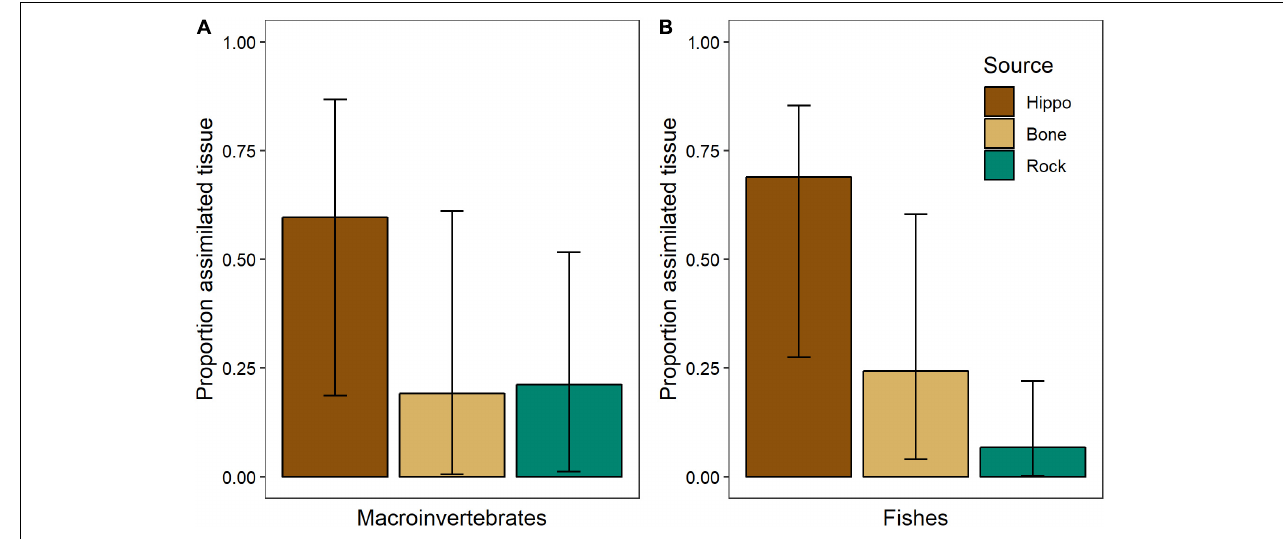
FIGURE 11 | Proportion of basal resources in assimilated tissue (mean and 95% Bayesian credible intervals) of (A) aquatic macroinvertebrates ( n = 4 taxa, composite samples of 16–30 individuals/taxa) and (B) fishes ( n = 3 taxa, 3–8 individuals/taxa) in February 2014 in the Mara River from hippo feces ( n = 9), bone biofilm ( n = 3), and rock biofilm ( n =